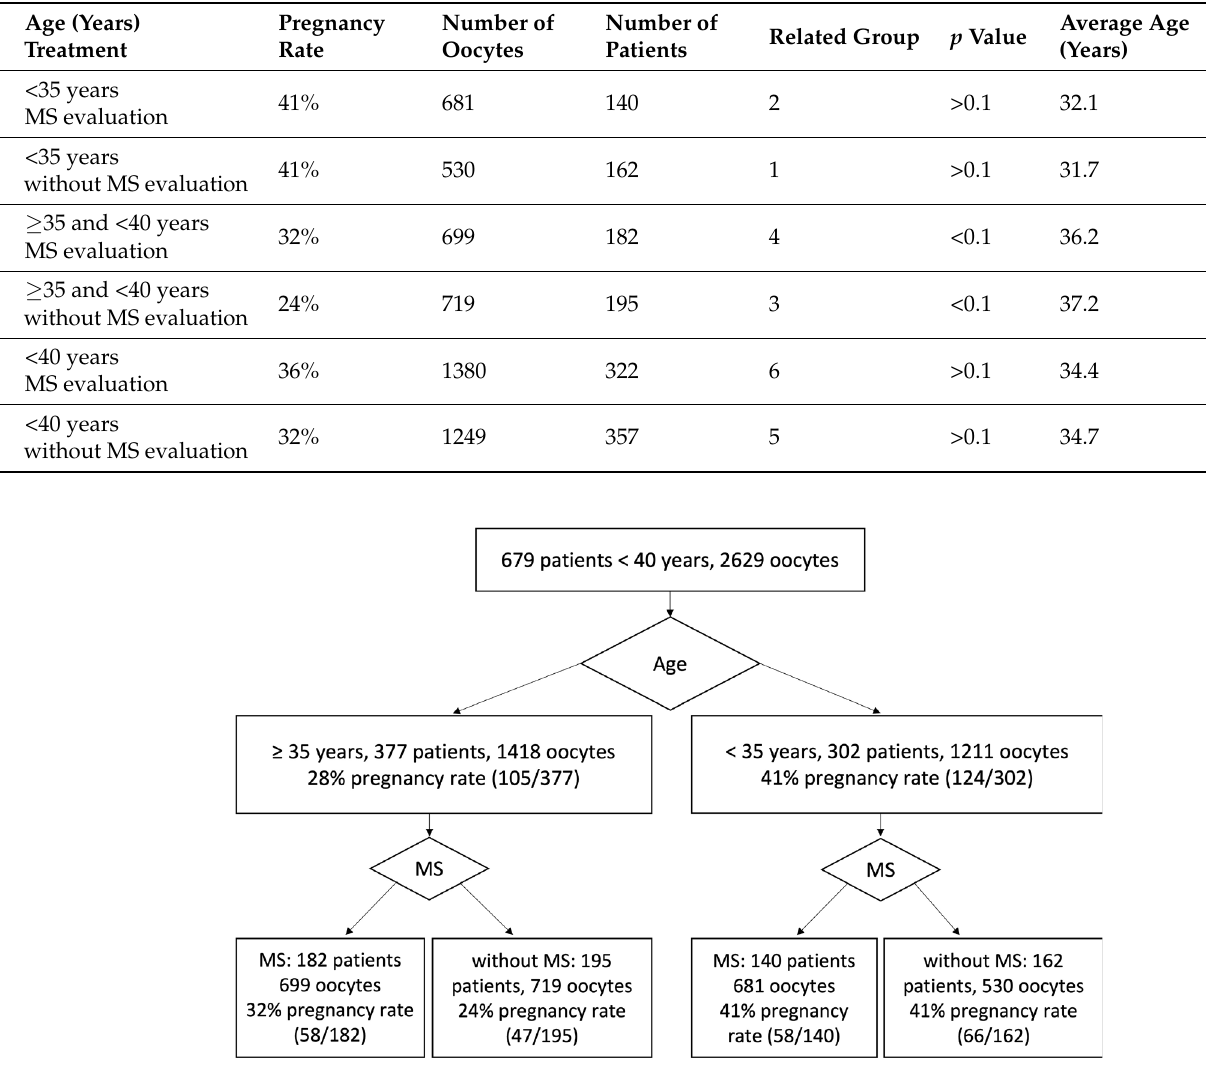
Figure 2. A total of 679 patients with planned ICSI fertilization were divided into two groups. In one group patients had time of ICSI determined on the basis of the relative position of PB and MS visibility. The second group was treated without MS evaluation. We compared the probability of clinical pregnancy for patients with the time of ICSI determined on the basis of the relative position of PB and MS and MS visibility with the probability of clinical pregnancy for patients without MS evaluation. The differences in pregnancy rates between patients < 35 treated with MS evaluation and with ICSI performed 5 – 6 h after OPU (pregnancy rate 43%) and patients < 35 treated with MS evaluation and with ICSI performed 7 – 8 h after OPU (pregnancy rate 40%) was